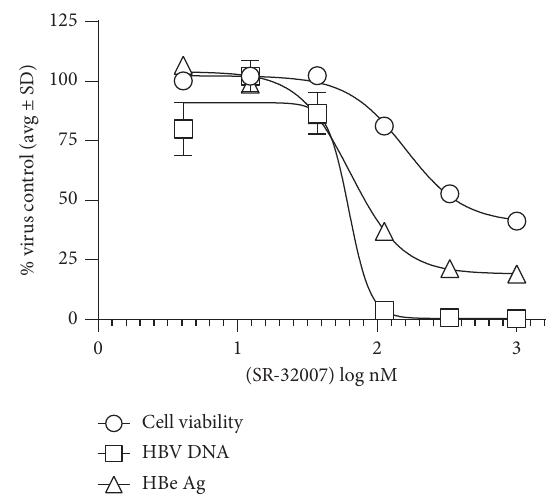
Figure 1: Antiviral activity of SRI-32007 against HBV genotype D in HepG2.2.2.15 cells. HepG2.2.2.15 cells in 96 wells were treated with different concentrations of SRI-32007 for six days followed by measurement of virus associated DNA in the culture supernatants by HBV specific qPCR. HBV DNA and HBe Ag levels in the treated samples and cell viability normalized to the untreated samples (average ± standard deviation from triplicate samples) are shown in the